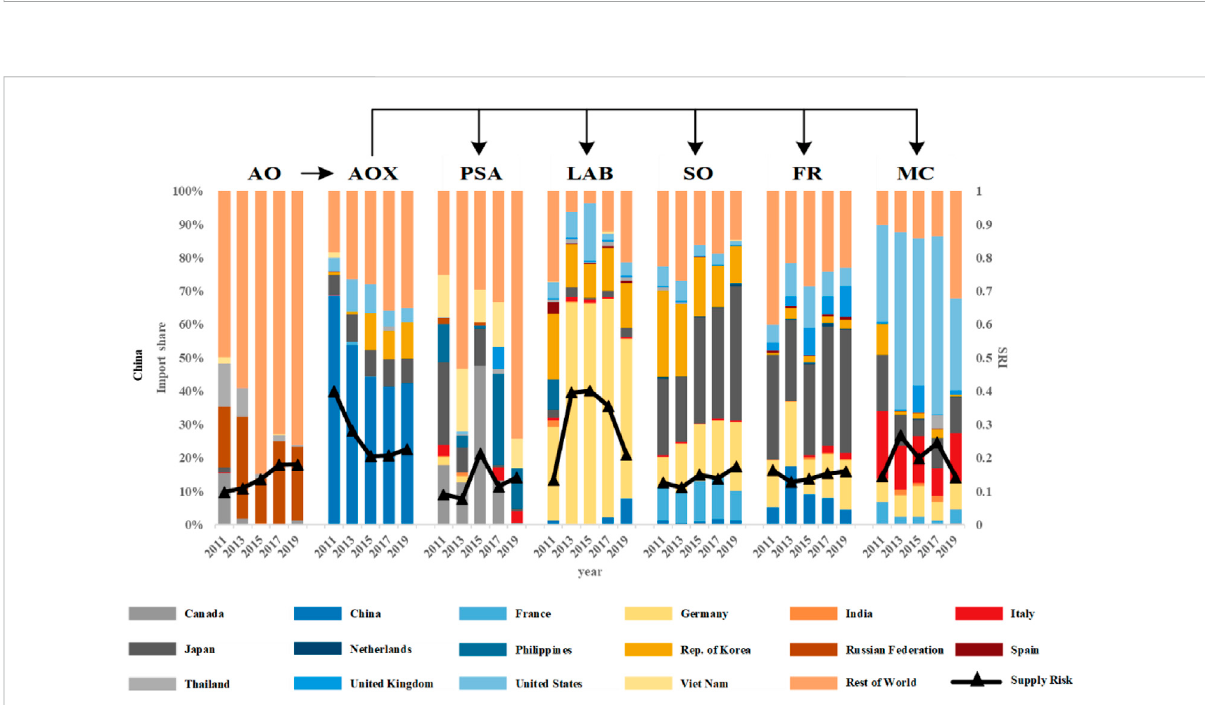
Import structures and risks of key commodities in the antimony industry chain in